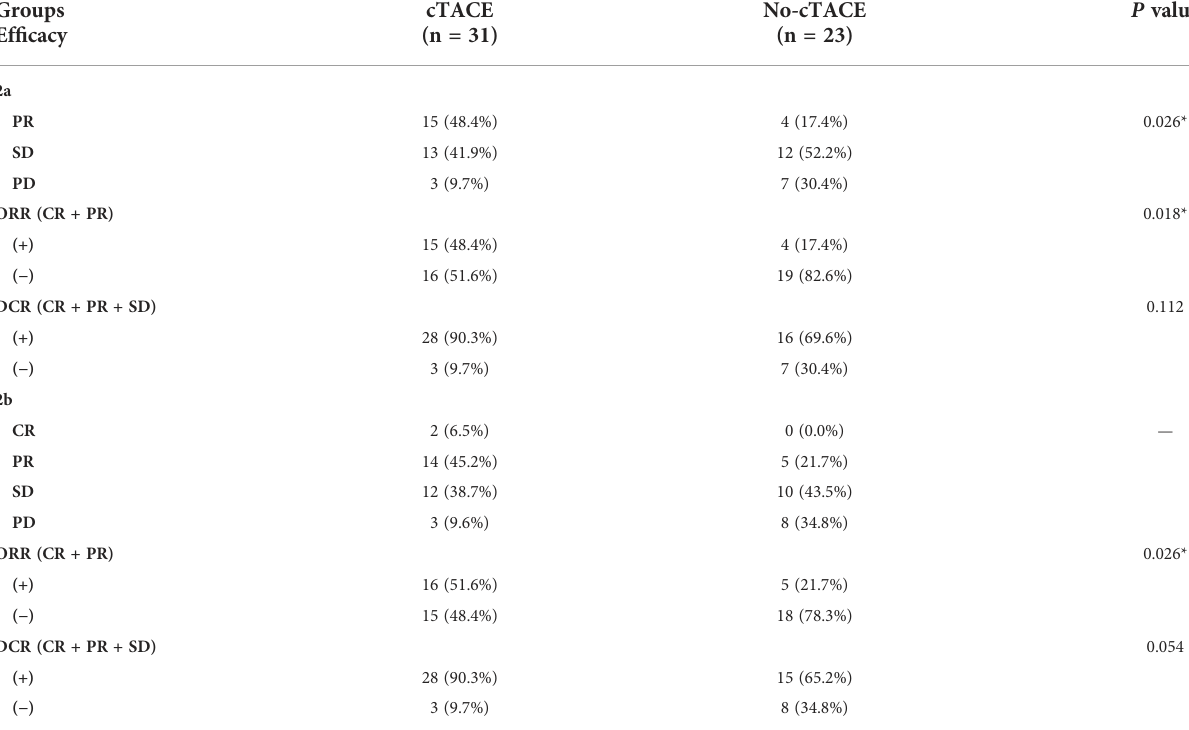
TABLE 2 Ef fi cacy of HCC patients with different treatment combinations (with two cycles of ICI). Groups Ef fi cacy